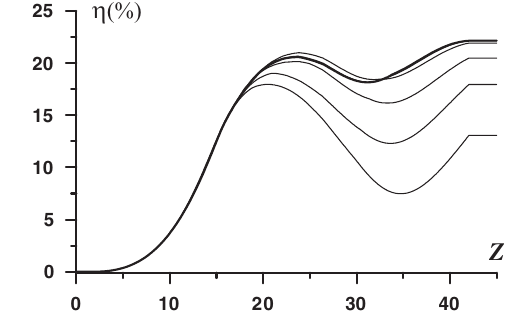
FIG. 11. FEL with a weak conventional guide field. Dependence of electron efficiency on longitudinal coordinate (for parameters given in Fig. 10) for the beam fractions with different initial parasitic transverse velocity at the entrance of the interaction space. The maximum initial parasitic transverse velocity equals 15% of the operating transverse velocity.